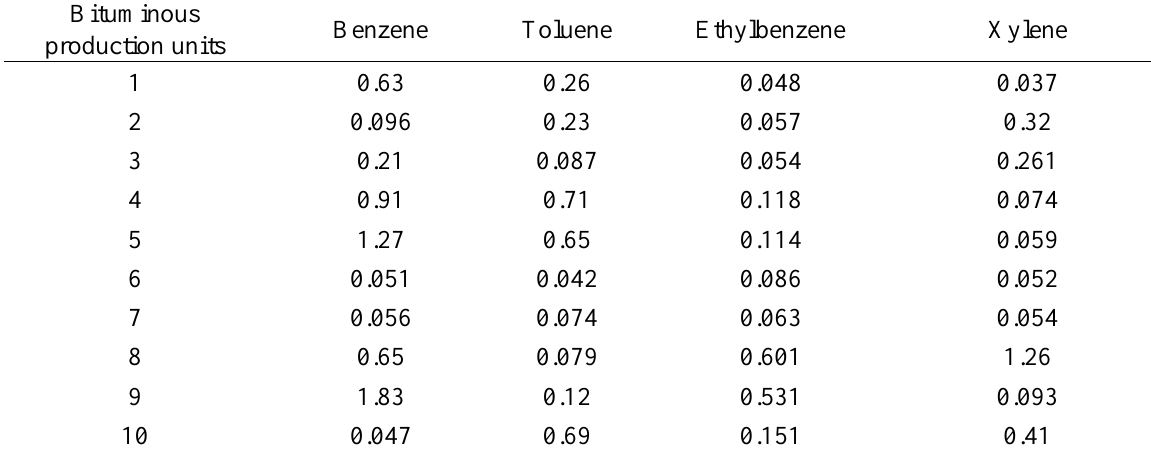
Table 3. Volume of measured values of exhaust gas concentration (PPb) Bituminous